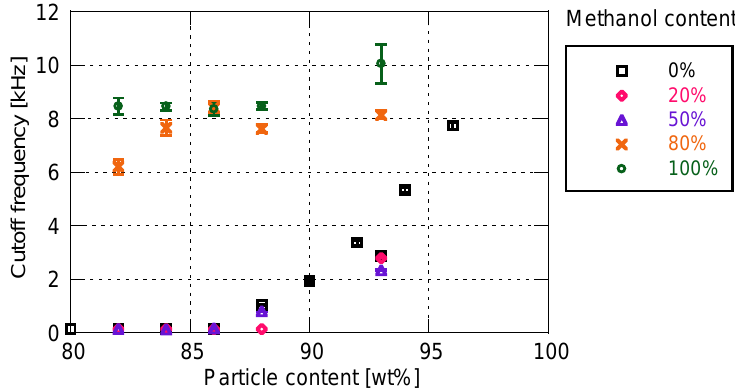
Figure 8. Cutoff frequency related to methanol content for particle/dye solution.